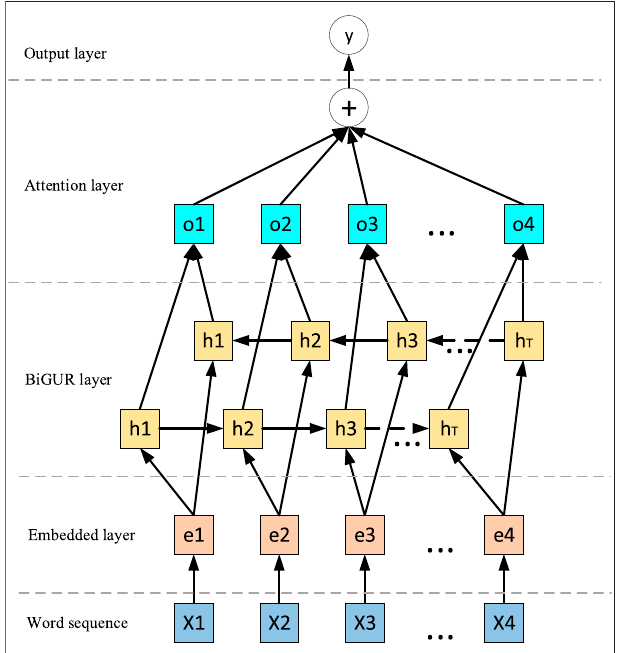
FIGURE 4 | BiGRU-Attention model